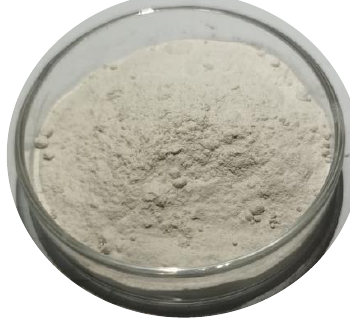
Figure 5. Picture of clinoptilolite. Table 2. The basic physical property indexes of the in situ clay and clinoptilolite.